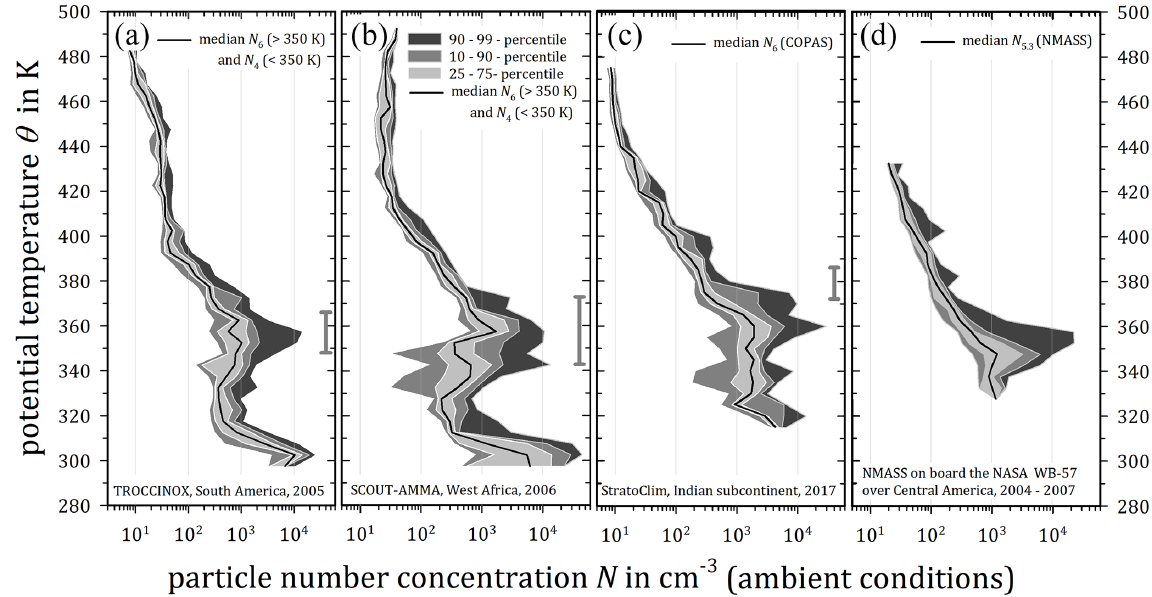
Figure 2. Synopsis of vertical profiles of the total number concentration (median with 10th, 25th, 75th, 90th, and 99th percentiles) of sub-micrometre-sized particles as a function of potential temperature obtained from condensation nuclei (CN) detections over (a) Brazil (TROCCINOX, 2005), over (b) West Africa (SCOUT-AMMA, 2006), and over (c) the Indian subcontinent (StratoClim 2017). During TROCCINOX (a) and SCOUT-AMMA (b) the number concentrations N 4 at lower heights ( θ < 350K) were measured aboard the DLR Falcon 20 (cf. Borrmann et al., 2010, and Weigel et al., 2011). All high-altitude measurements ( θ > 350K) from the M-55 Geophysica and the entire StratoClim 2017 data set result from COPAS measurements. (c) The median profile of N 5 . 3 from repeated measurements (over the years 2004–2007) with the NMASS multi-channel CN counter over Central America (aboard the NASA WB-57F; data courtesy of J. C. Wilson, Denver University, 2011). All number concentrations are given at ambient